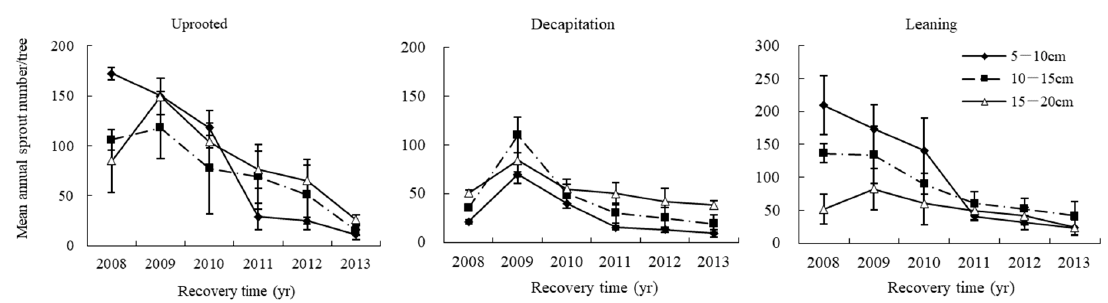
Figure 10. The annual dynamics of mean accumulative total sprout number for three diameter classes of uprooted, leaning and decapitation damaged trees.